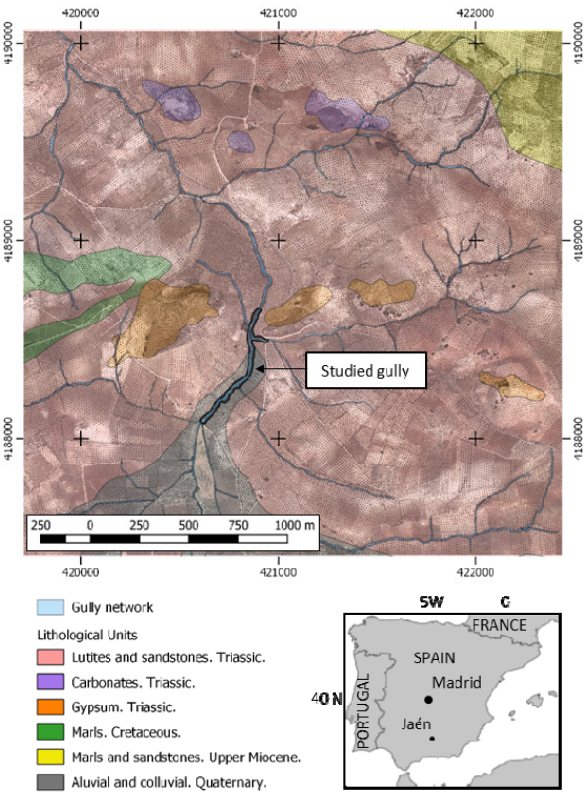
Figure 1. Geographical location of the studied area. Orthoimage of the area is overlayed with the geological units.